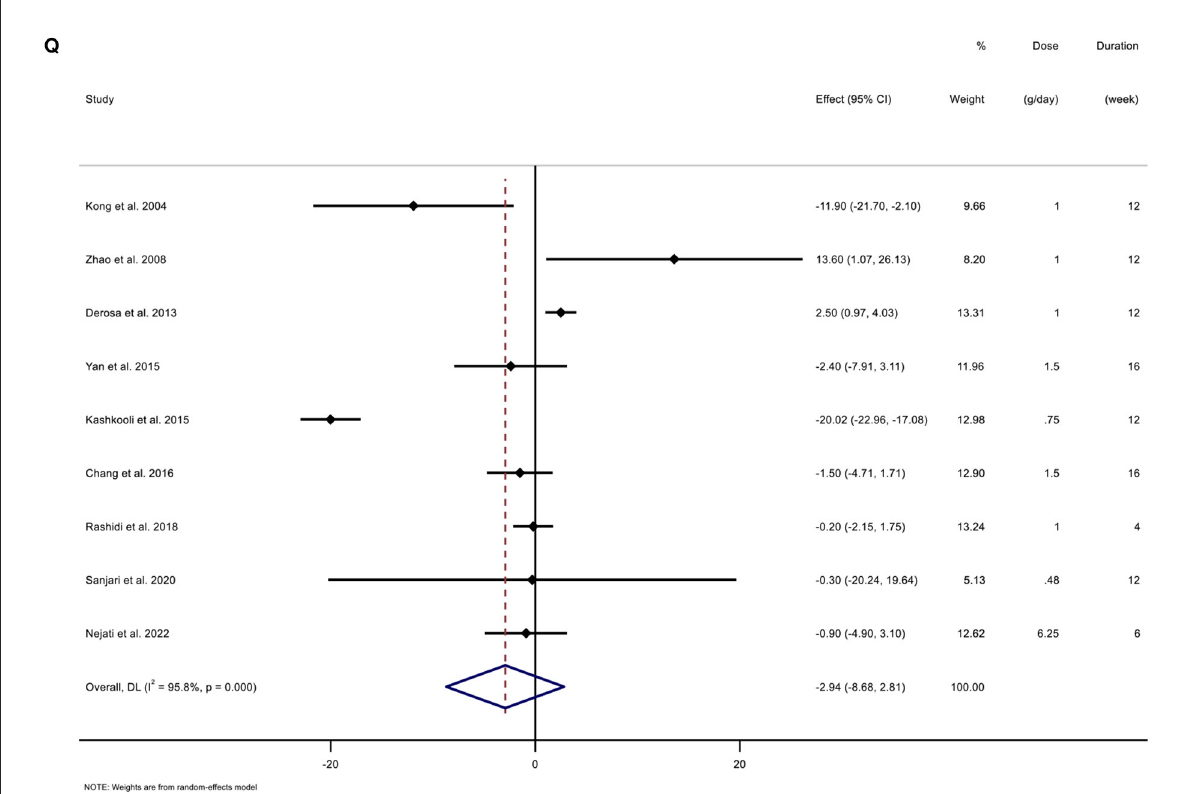
FIGURE2 Forest plot detailing weighted mean difference (WMD) and 95% confidence intervals (CIs) for the effect of berberine consumption on (A) TG (mg/dl); (B) TC (mg/dl); (C) LDL (mg/dl); (D) HDL (mg/dl); (E) FBG (mg/dl); (F) Insulin (mg/dl); (G) HbA1c (%); (H) HOMA-IR; (I) SBP (mmHg); (J) DBP (mmHg); (K) CRP (mg/L); (L) IL-6 (ng/L); (M) weight (kg); (N) BMI (kg/m 2 ); (O) WC (cm); (P) ALT (U/L); and (Q) AST (U/L). TG, triglyceride; TC, total cholesterol; LDL, low-density lipoprotein; HDL, high-density lipoprotein; FBG, fasting blood glucose; HOMA-IR, homeostasis model assessment for insulin resistance; hemoglobin A1c, HbA1c; CRP, C-reactive protein; IL-6, interleukin 6; WC, waist circumference; ALT, alanine transaminase; AST, aspartate transaminase; SBP, systolic blood pressure; DBP, diastolic blood pressure; CI, confidence interval, weighted mean difference;